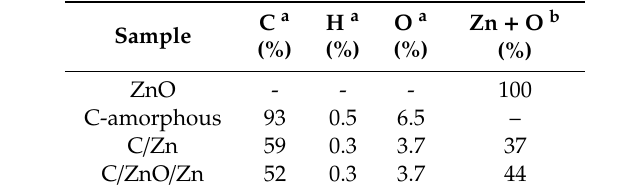
Table 5. Summary of the photocatalysts´ composition.